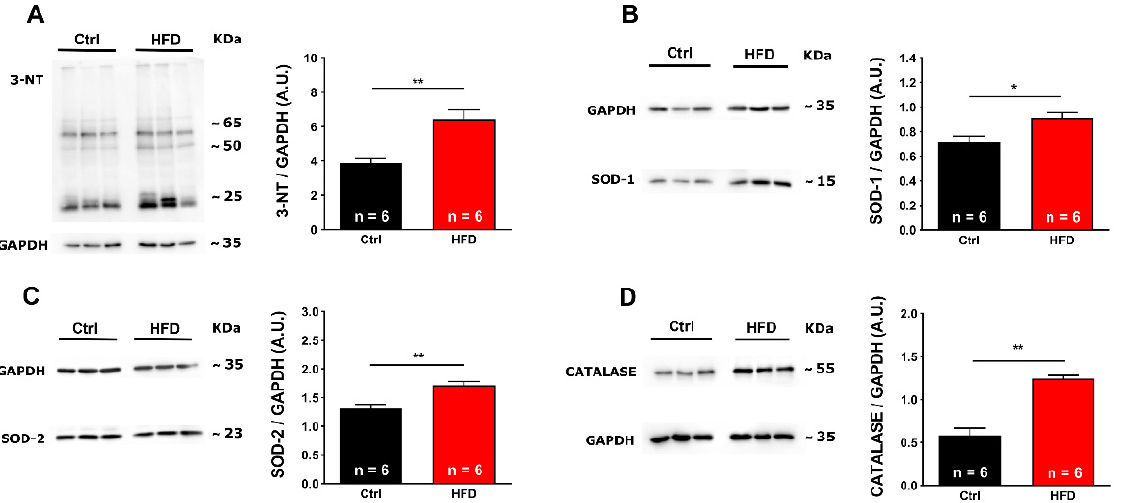
Figure 4. Markers of oxidative stress in EDL muscles. Representative immunoblots ( left ) and relative band densities normalized to GAPDH levels ( right ) of 3-NT (panel ( A )), SOD-1 (panel ( B )), SOD-2 (panel ( C )), and Catalase (panel ( D )) in EDL muscle homogenates. Data are shown as mean ± SEM (* p < 0.05 and ** p < 0.01), as evaluated by two-tailed unpaired Student’s t -test. n = number of EDL muscles.